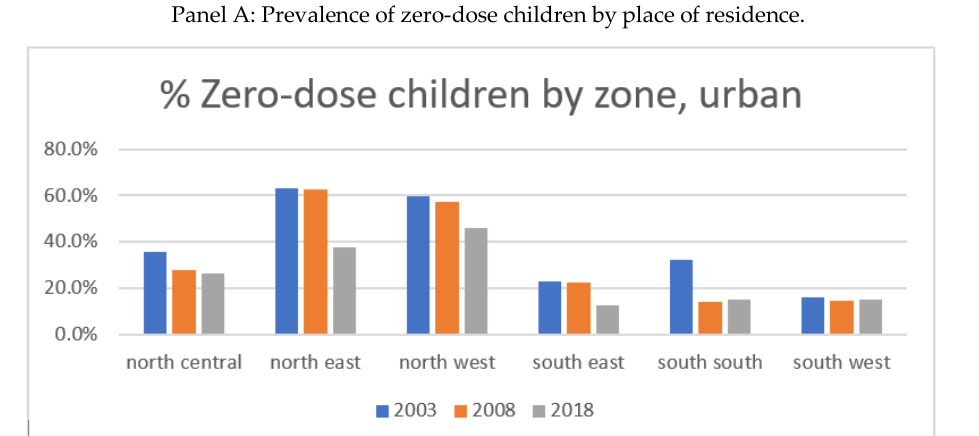
Table 1. Determinants of zero-dose children.